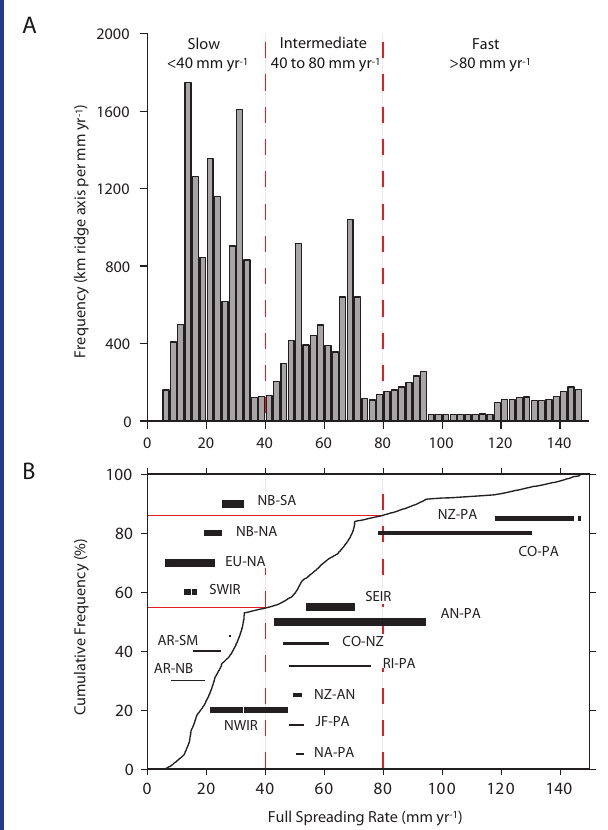
Figure 2. Distribution of spreading rates for major active plate boundaries, presented in [A] histogram form and as [B] cumulative distribution. The rates are the best-fit rates of the MORVEL model (DeMets et al., 2010), and ridge length is measured as the component perpendicular to spreading direction. Horizontal lines on the cumulative plot show the range of spreading rate for each plate pair, with line width scaled approximately to plate boundary length. Plate-pair labels follow the MORVEL convention, except in the Indian Ocean where the southeast, southwest, and northwest branches of the ridge system are grouped for 2–3 plate pairs to simplify